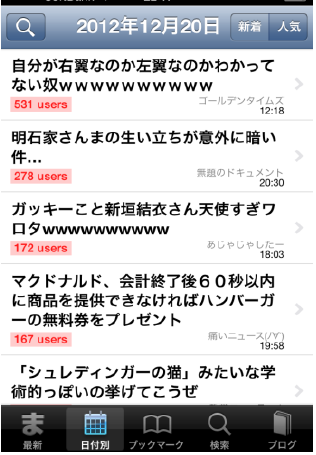
Figure 1. MT2 app view of most popular edited thread blog titles of the